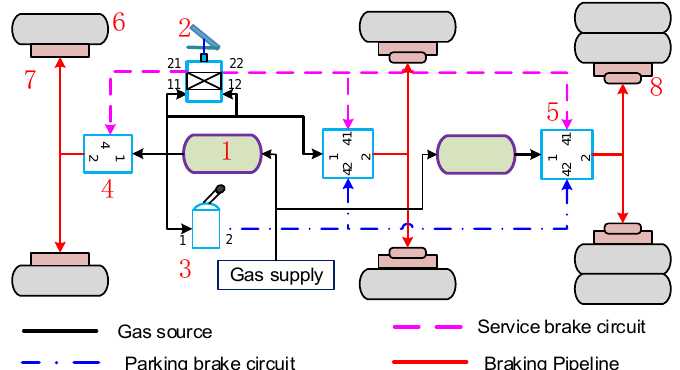
Figure 1. Schematic diagram of a pneumatic braking system (PBS) on a multi-axle heavy vehicle (MHV) (1—gas reservoir; 2—Treadle valve; 3—Hand brake valve; 4—Relay valve; 5—Delay relay valve; 6—Wheel; 7—Brake chamber; 8—Spring brake chamber).